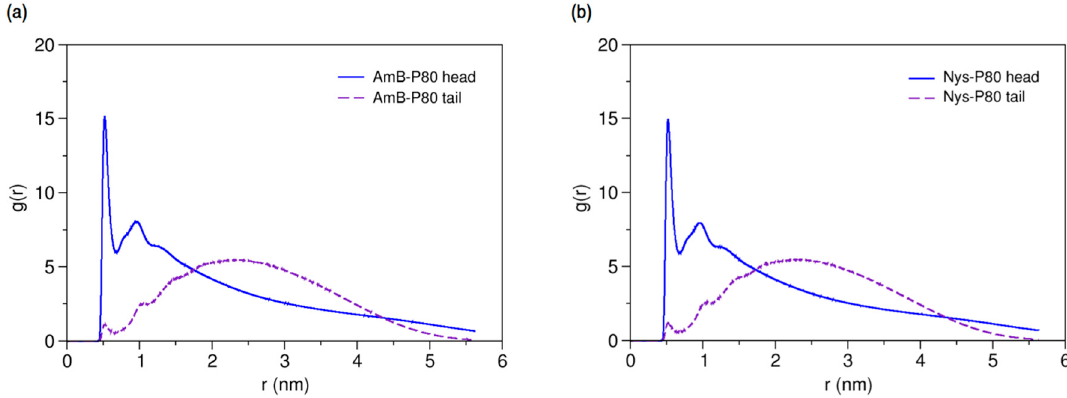
Figure 14. Radial distribution functions for head and tail of P80 against ( a ) AmB; and ( b ) Nys in P80 60 -AmB 9 and P80 60 -Nys 9 mixed micelles, respectively.